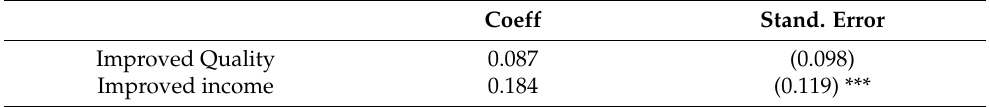
Table 7. Dependent variable: tree density. Coeff Stand. Error Improved Quality 0.087 (0.098) Improved income